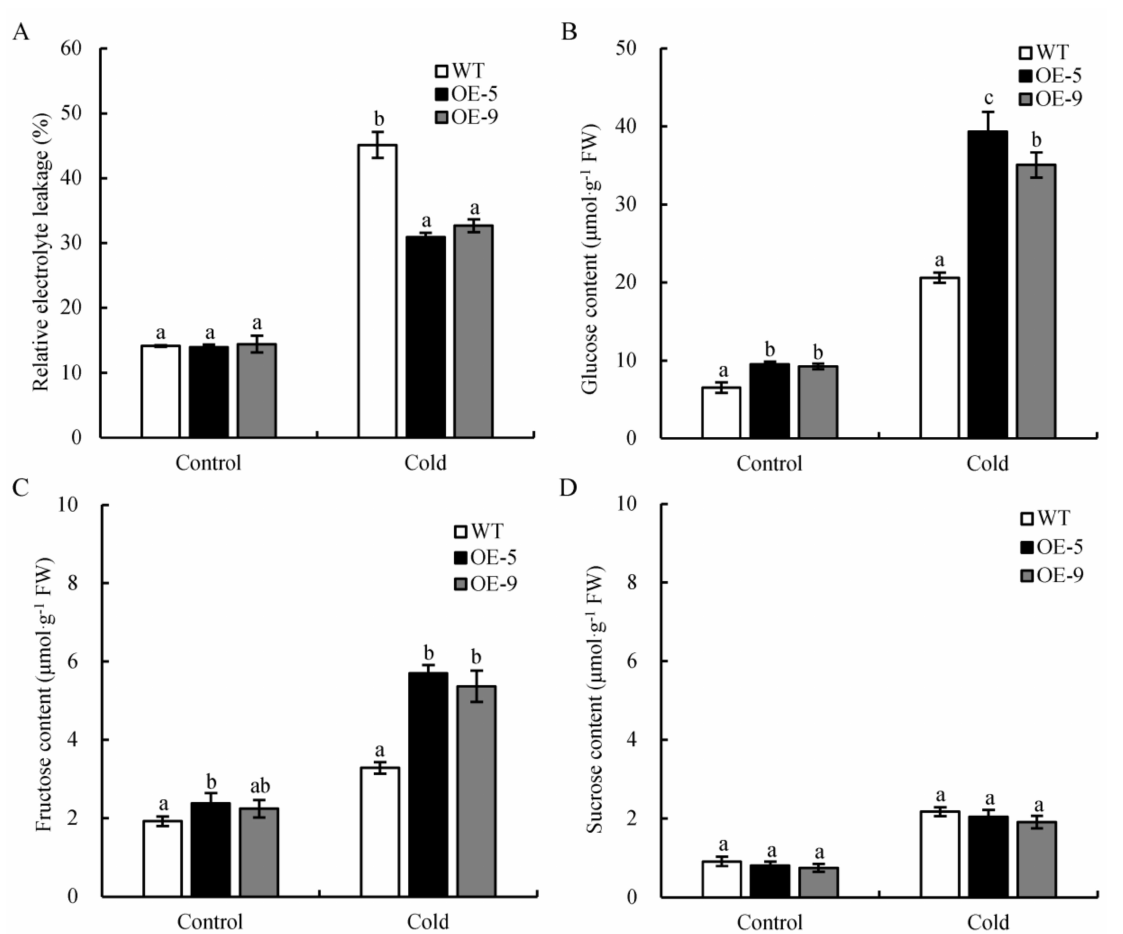
Figure 6. Analysis of the relative electrolyte leakage (REL) levels and sugar contents in CsSWEET2 - overexpressing ( CsSWEET2 -OE) lines and wild-type (WT) plants. The four-week-old plants were grown at 4 ◦ C for 4 days for cold-stress treatment, after which the whole shoots were collected for measurements of REL and sugar contents. ( A ) REL levels. ( B – D ) Contents of glucose ( B ), fructose ( C ), and sucrose ( D ). The data are presented as the means ± SDs of three replicates. The different letters above the bars indicate significant differences ( p <